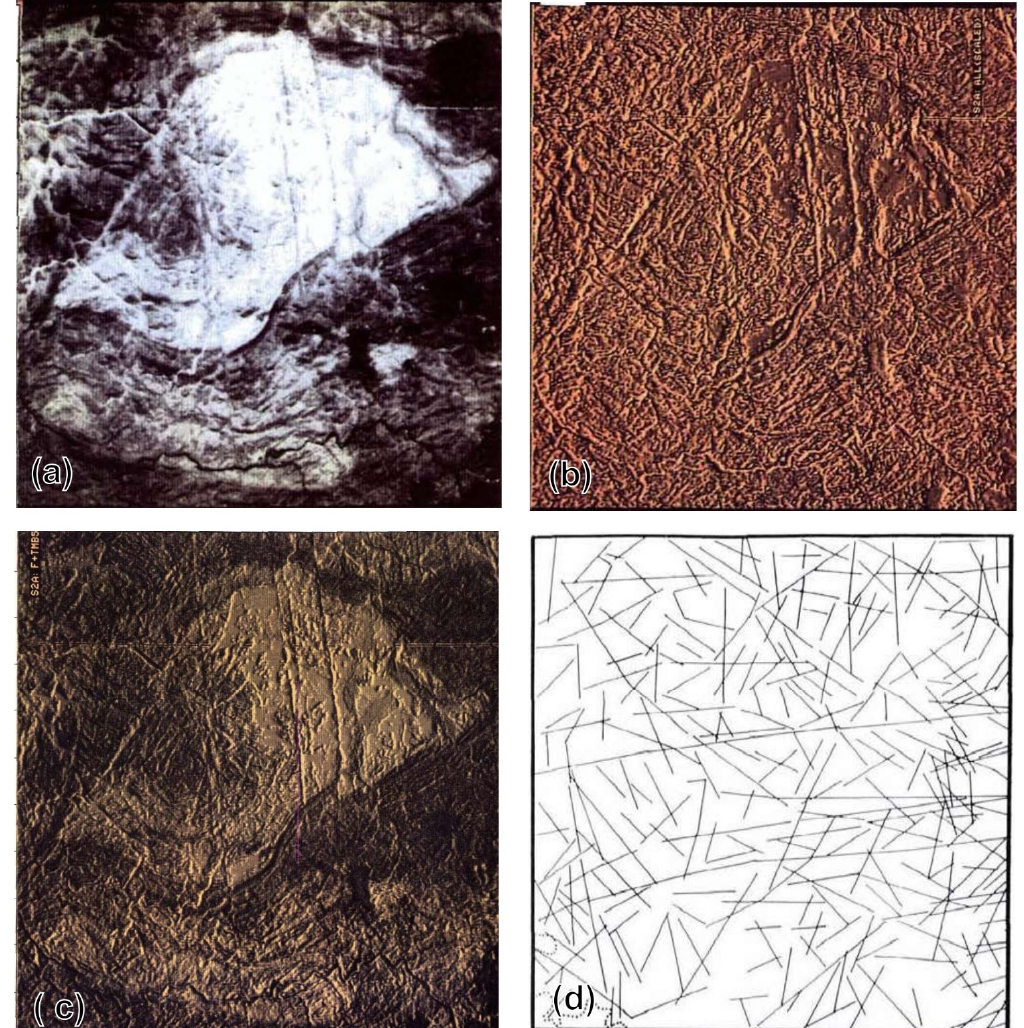
Figure 4. Application of Landsat TM band 5 for geological lineament extraction using high pass filtering within the Al–Khabt area, Southern Arabian Shield modified from [75]; ( a ) original image, ( b ) filtered image, ( c ) filtered image superimposed on TM band 5, and ( d ) extracted geological lineaments.